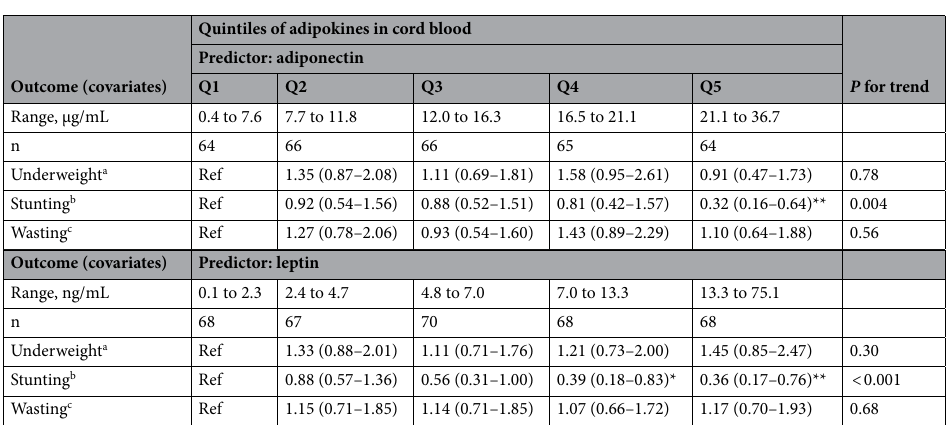
Table 3. Multivariable generalized estimated equation models of adiponectin and leptin quintiles predicting underweight, stunting, and wasting during infancy. a Adjusted for maternal age, socioeconomic status (SES), sex, and weight-for-age z-score at birth. b Adjusted for SES, premature, exclusively breastfeeding, and height- for-age z-score at birth. c Adjusted for maternal age and